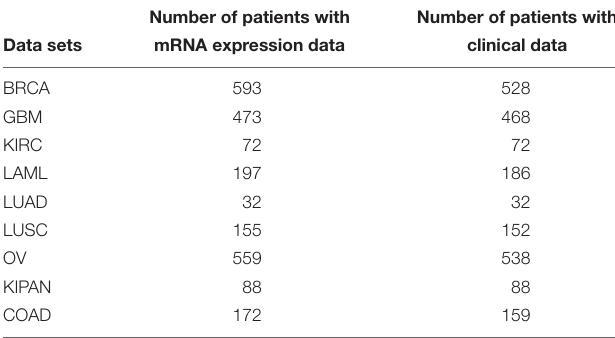
TABLE 1 | Details of the cancer data